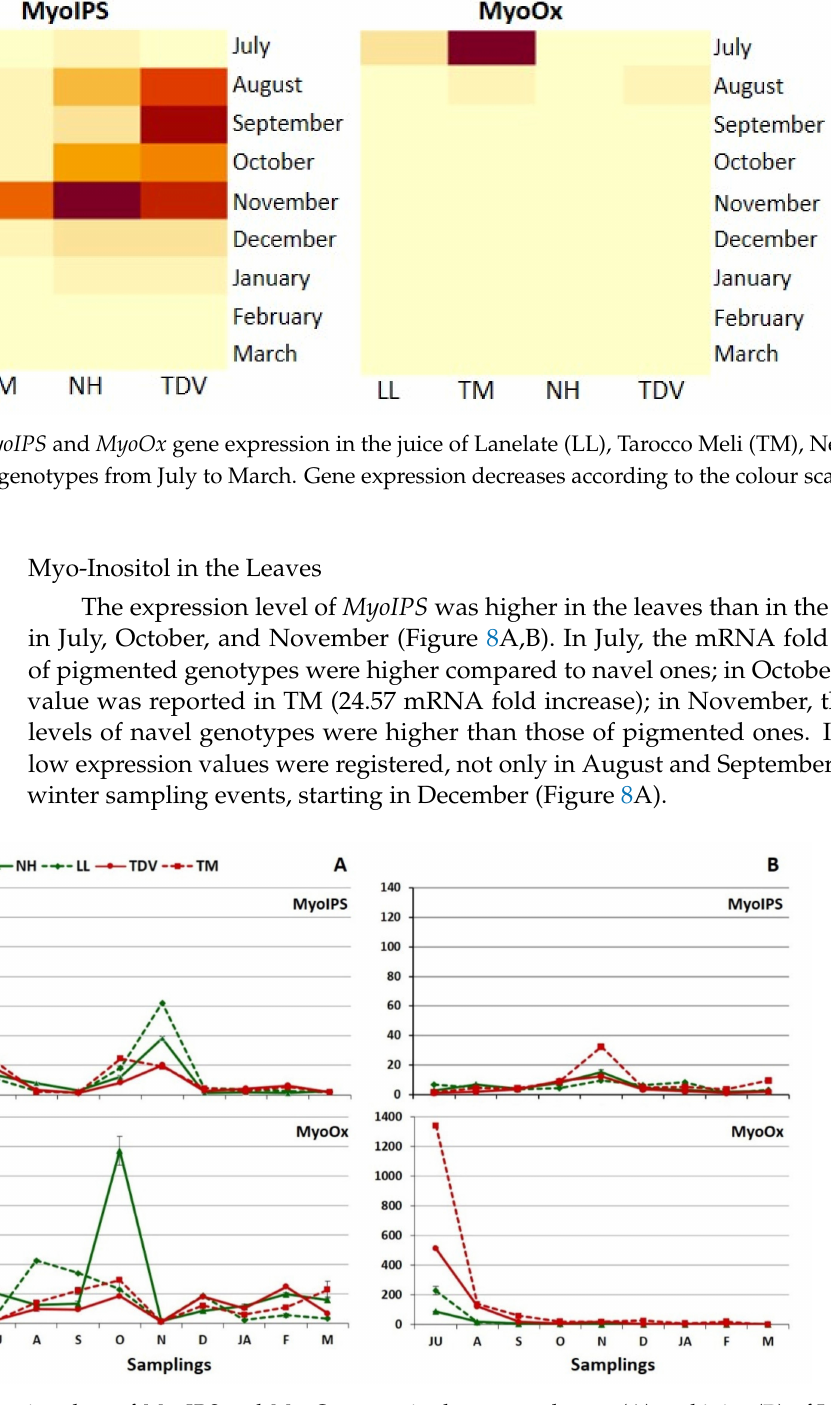
Figure 8. Real-time expression data of MyoIPS and MyoOx genes in the mature leaves ( A ) and juice ( B ) of Lanelate (LL), Tarocco Meli (TM), Newhall (NH), and Tarocco TDV (TDV) genotypes during sampling from July to March. The data are the mean ± S.E. of at least three